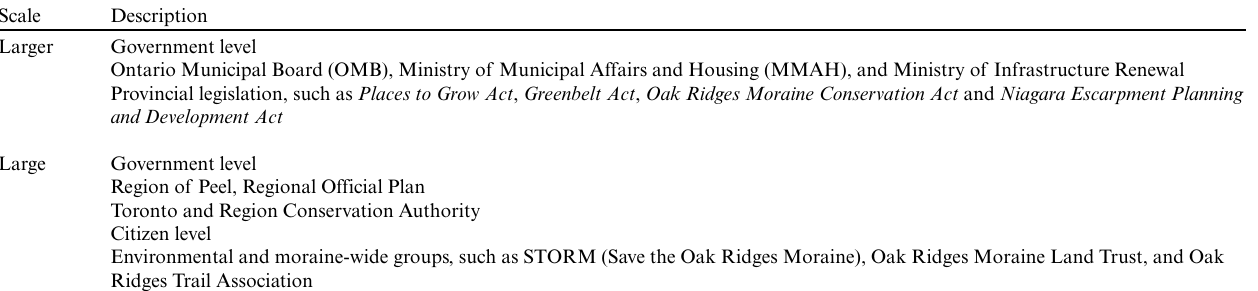
Table 3. Scales in the social domain of Caledon in the context of urban growth Scale